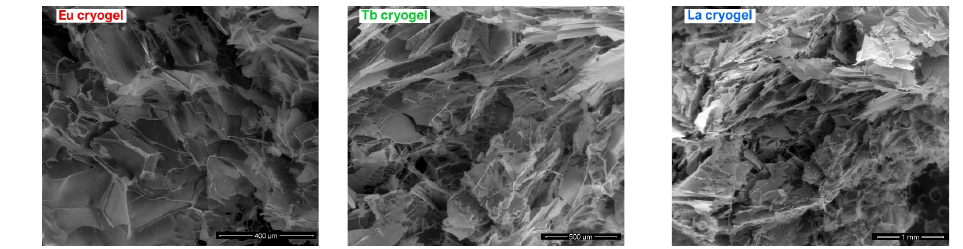
Figure 3. SEM micrographs of the prepared photoluminescent